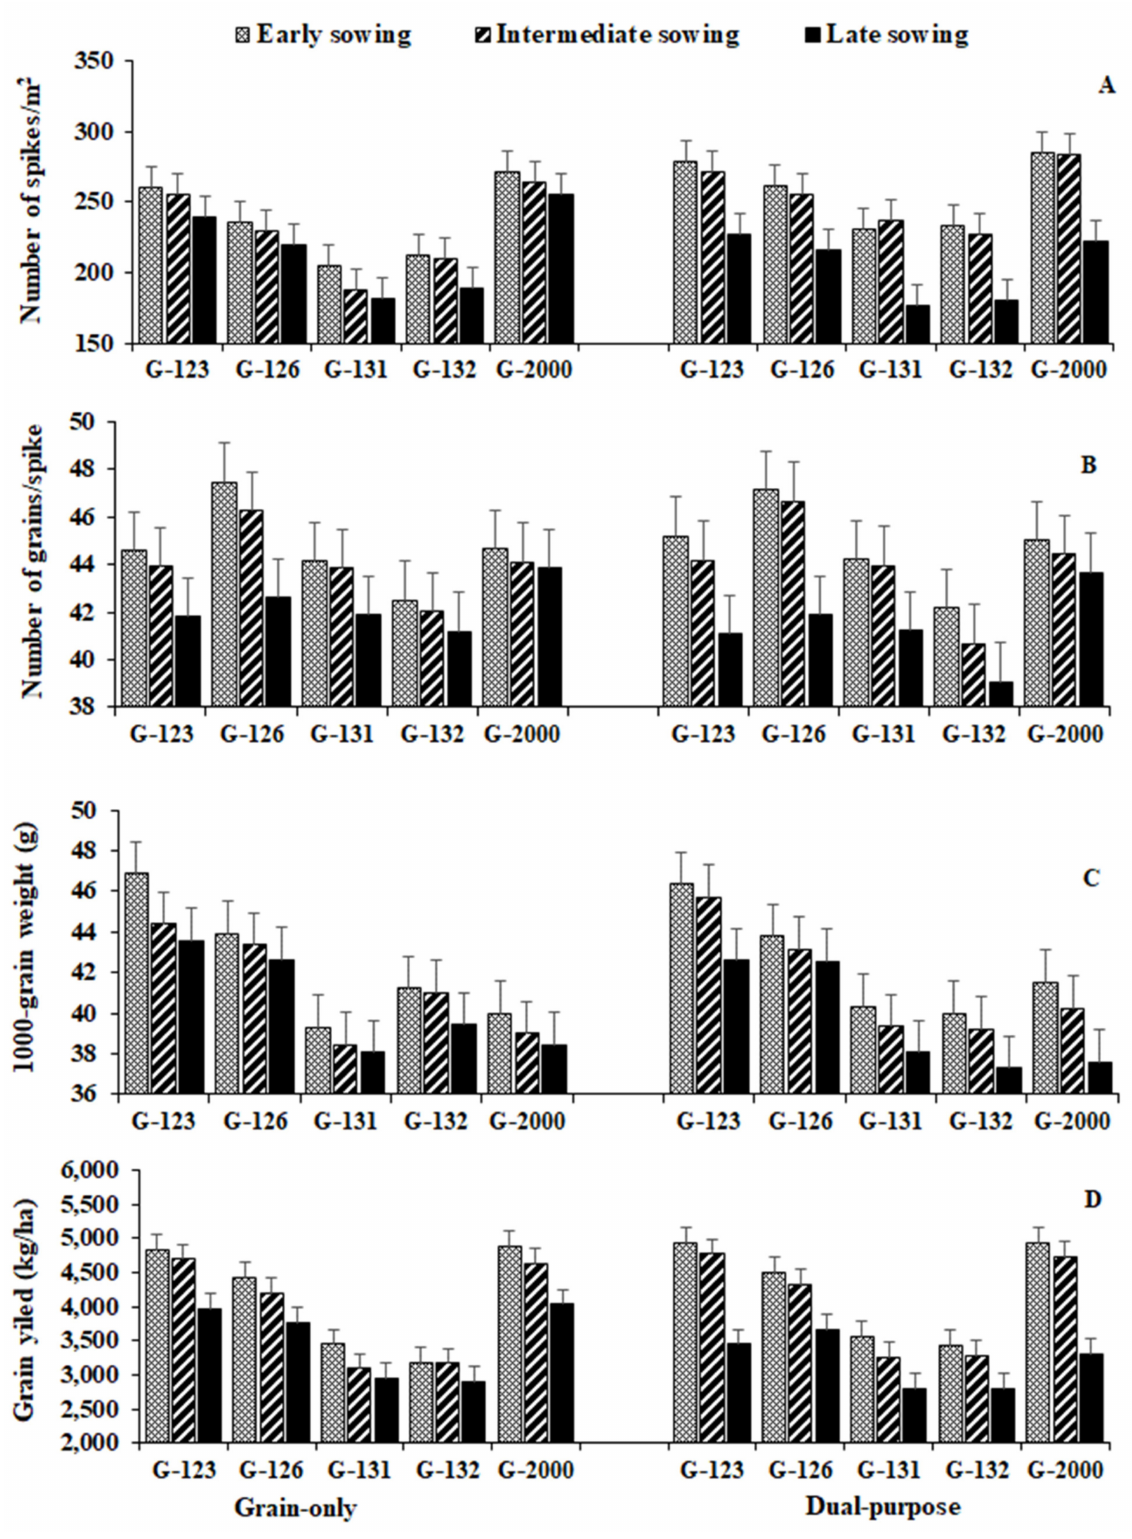
Figure 2. Influence of sowing date and forage cutting on number of spikes per square meter ( A ), number of grains per spike ( B ), 1000-grain weight ( C ), and grain yield ( D ) in five barley genotypes under salinity conditions averaged over the two growing